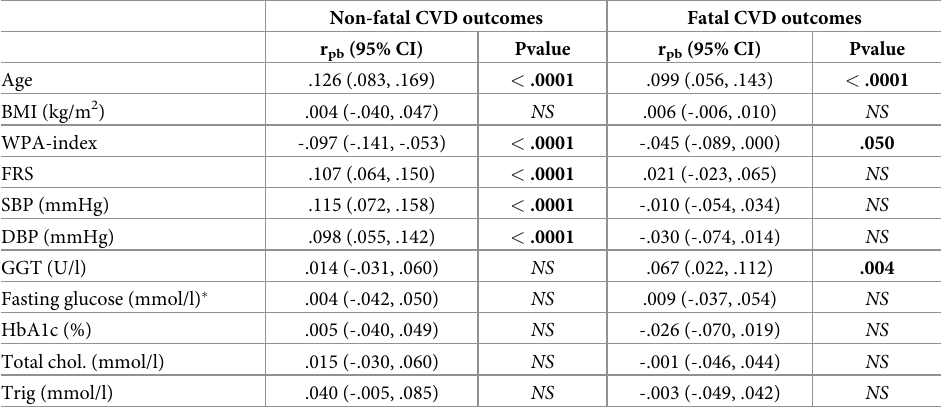
Table 2. Point-biserial correlations with 95% confidence limits between CVD outcomes and sample’s